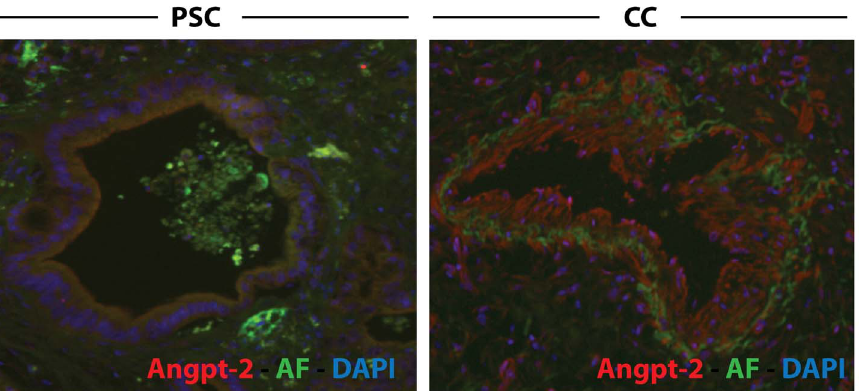
Figure 3. Angpt-2 expression in human CC samples. In human biopsies Angpt-2 expression is induced within CC vasculature. Fluorescent immunohistochemistry for Angiopoietin-2 (Angpt-2) showing an exemplary biopsy sample from individuals with primary sclerosis cholangitis (PSC, left panel) and cholangiocarcinoma (CC, right panel). Nuclear staining (DAPI) is shown in blue, tissue autofluorescence (AF) in green.